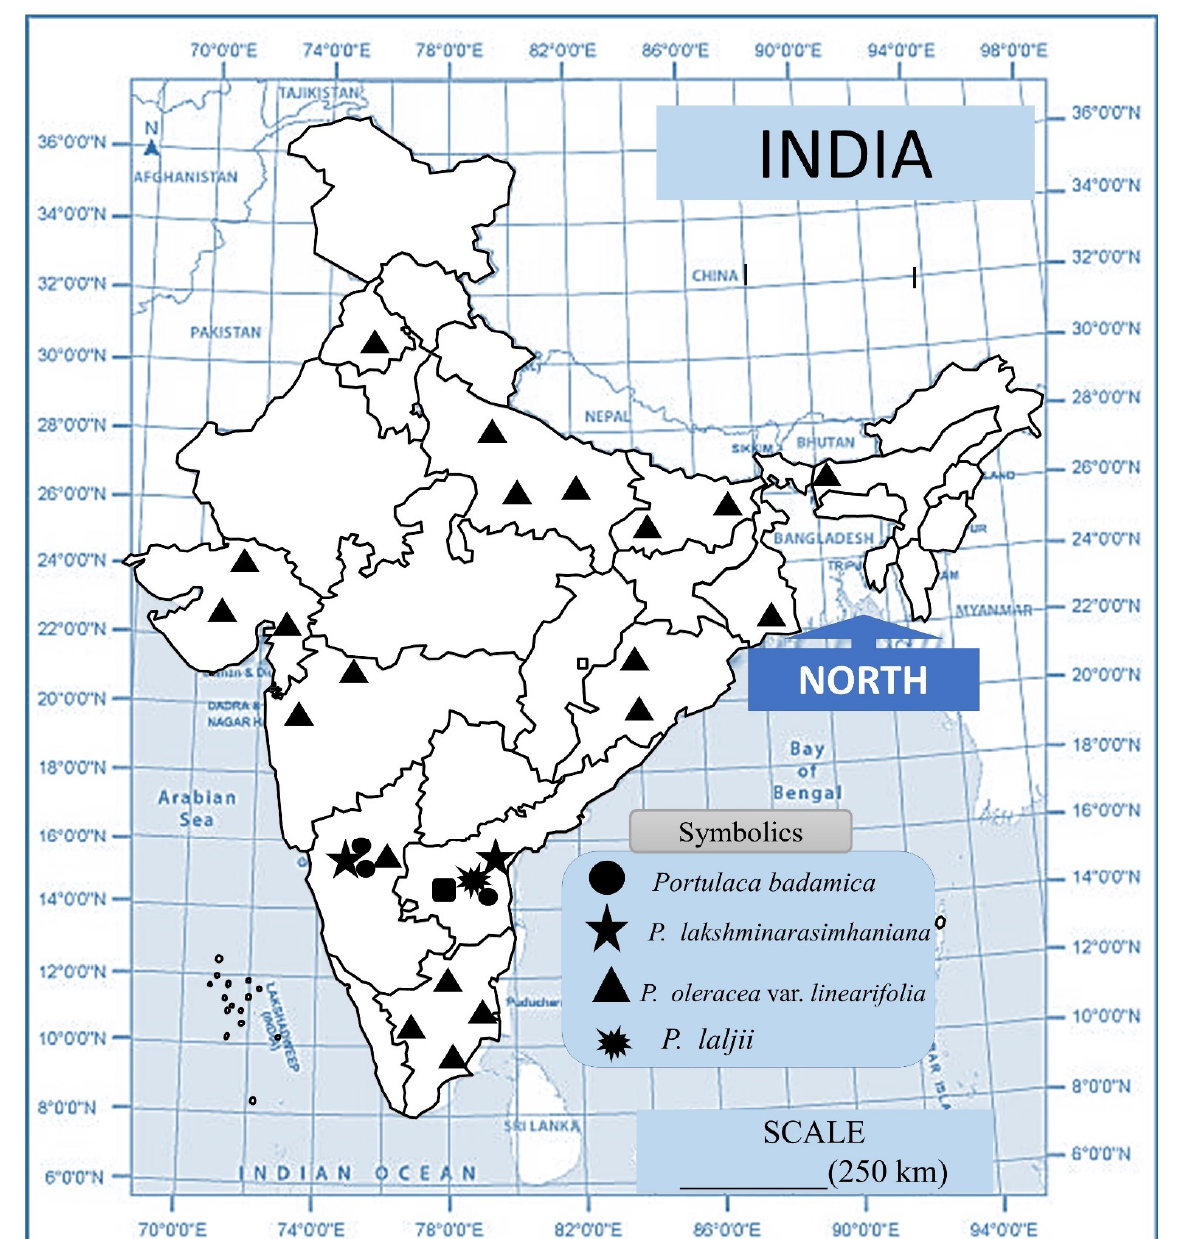
Figure 6. Distribution map of Indian endemic Portulaca species: Portulaca badamica, Portulaca